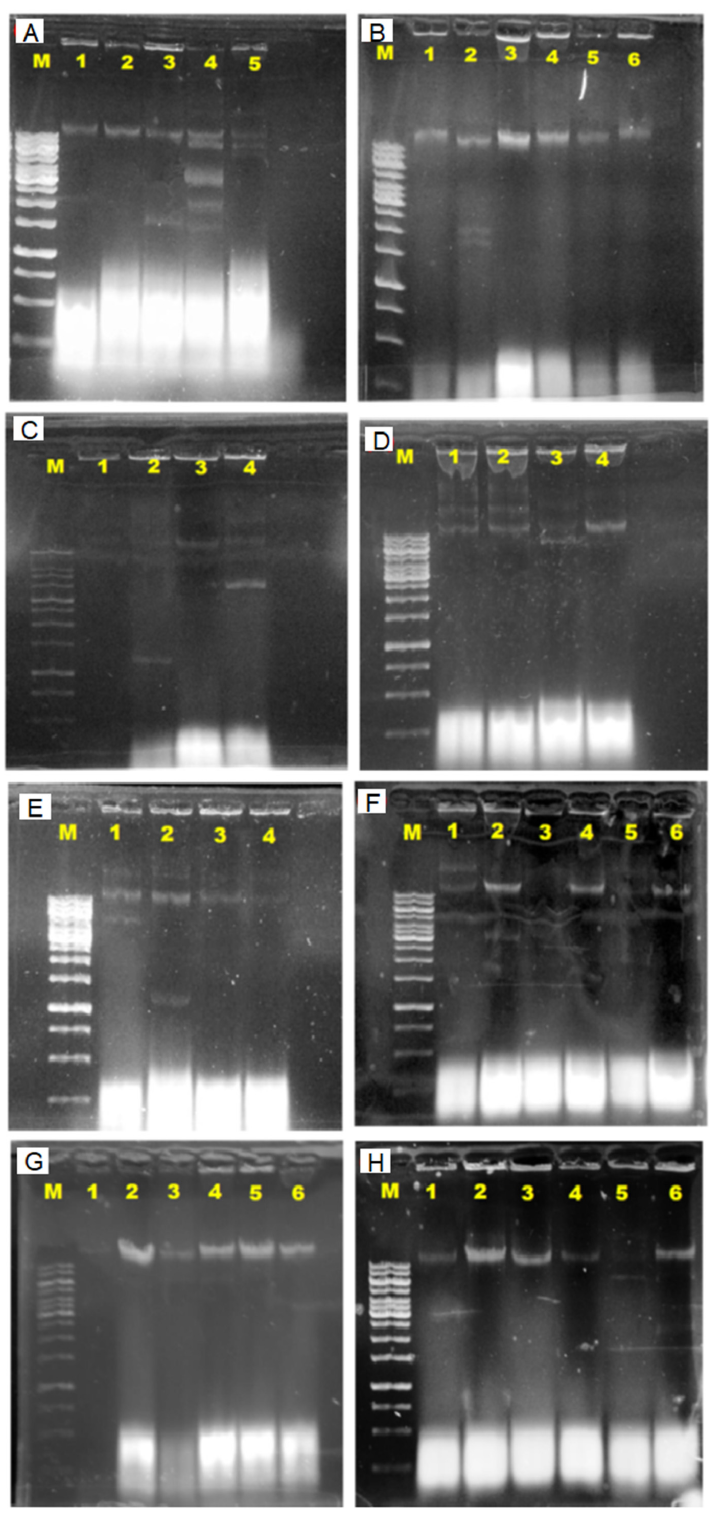
Figure 6. Agarose gel electrophoresis photograph of the estimated molecular weight (1.1- >10 kb) of the plasmid fragments in Escherichia coli isolated from Sarawak rivers and aquaculture farms. The plasmid DNA band shown above the chromosomal DNA band was estimated to carry >10 kb molecular